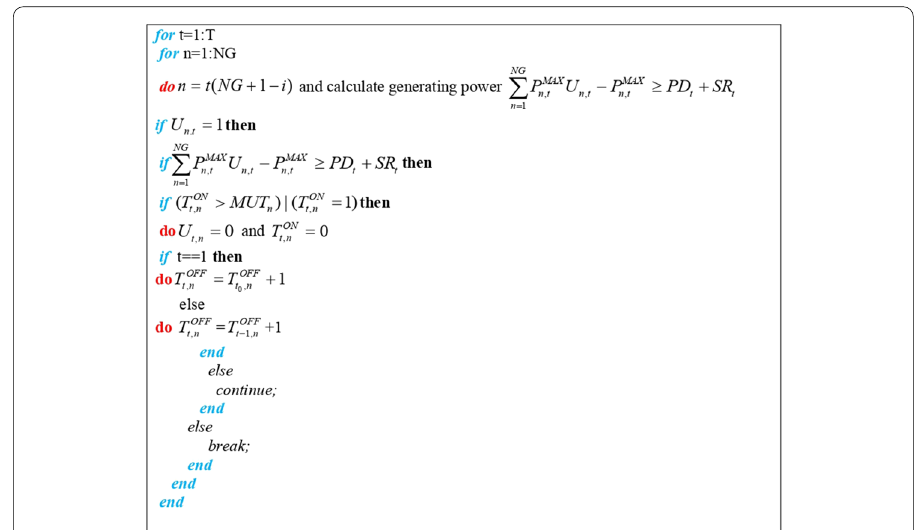
Fig. 9 Pseudocode of decommitment for excessive power generating unit